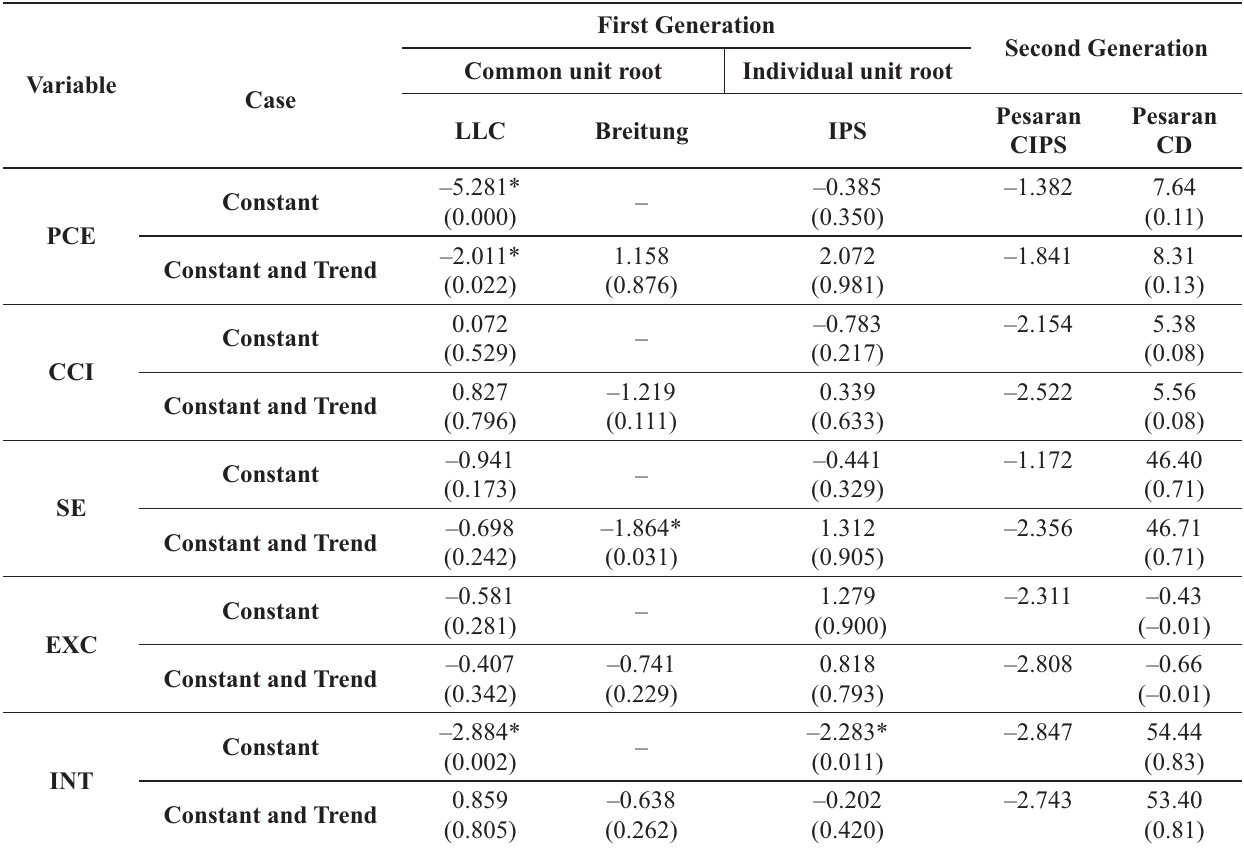
Table 1. Panel Unit Root Tests in